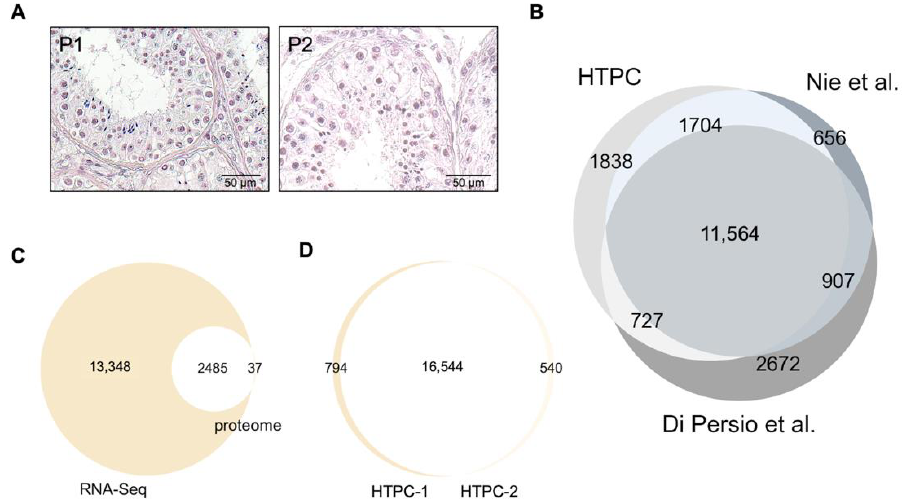
Figure 1. ( A ): H.&E. staining of seminiferous tubules of testes samples of which HTPC-1 (P1) and HTPC-2 (P2) were derived from. They show ongoing spermatogenesis and normal morphology of the tubular wall. ( B ): Venn diagram of in vitro data of HTPCs (HTPC-1, no FCS) and previously published ex vivo data [3,17]. Please, note that the extent of the differences between the two ex vivo datasets are similar to the differences between our data and the ex vivo data. ( C ): Overlap of scRNAseq data with proteomic data of the same donor [22]. ( D ): Similarity of HTPC-1-derived and HTPC-2-derived transcripts (14,916 common transcripts and 324 or 917, respectively, unique ones).